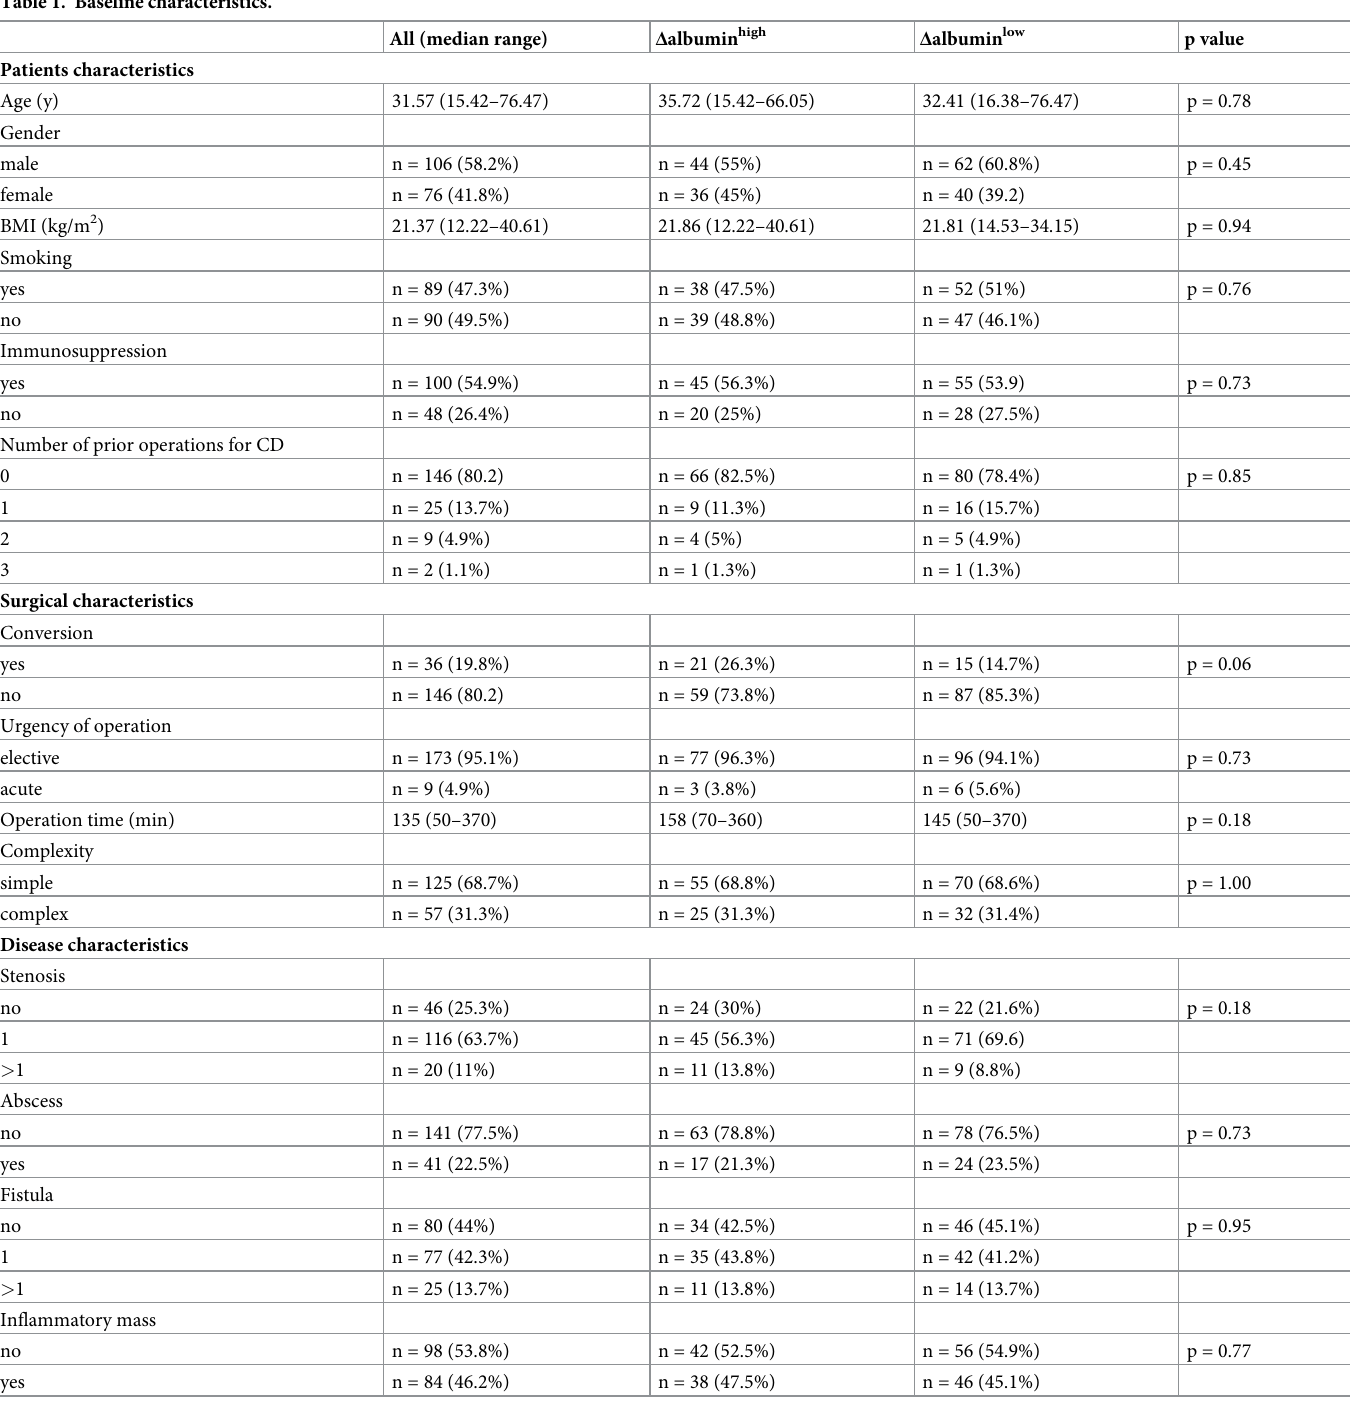
Table 1. Baseline characteristics.